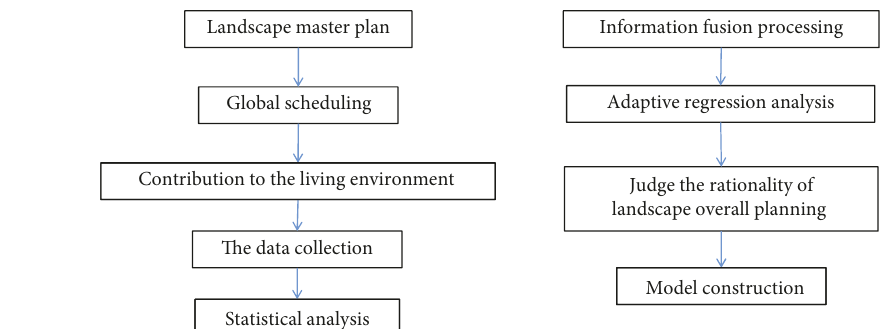
Figure 3: Implementation process of landscape design.